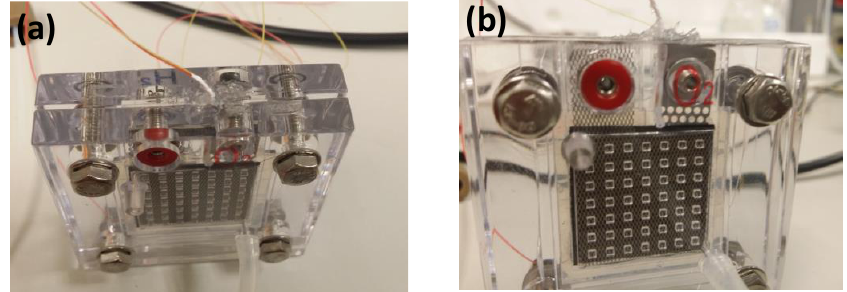
Figure 3. Image of the single cell with the device under test and the thermocouple insertion ( a ) Top view, ( b ) Front view.